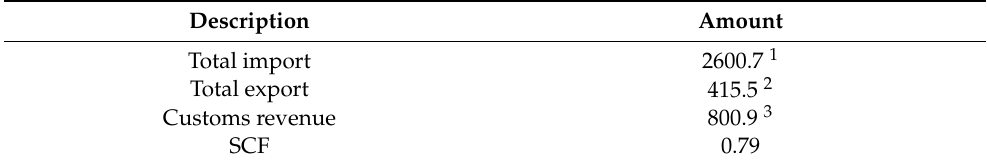
Table 9. SCF calculation.